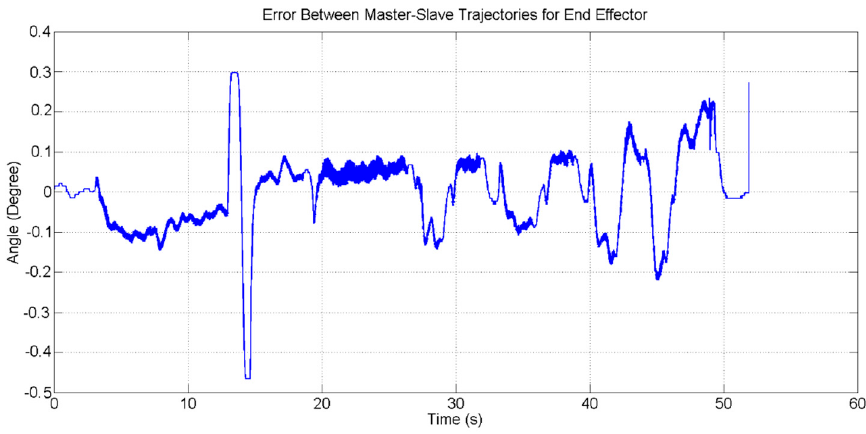
Figure 12. Error between master–slave trajectories for end effector.